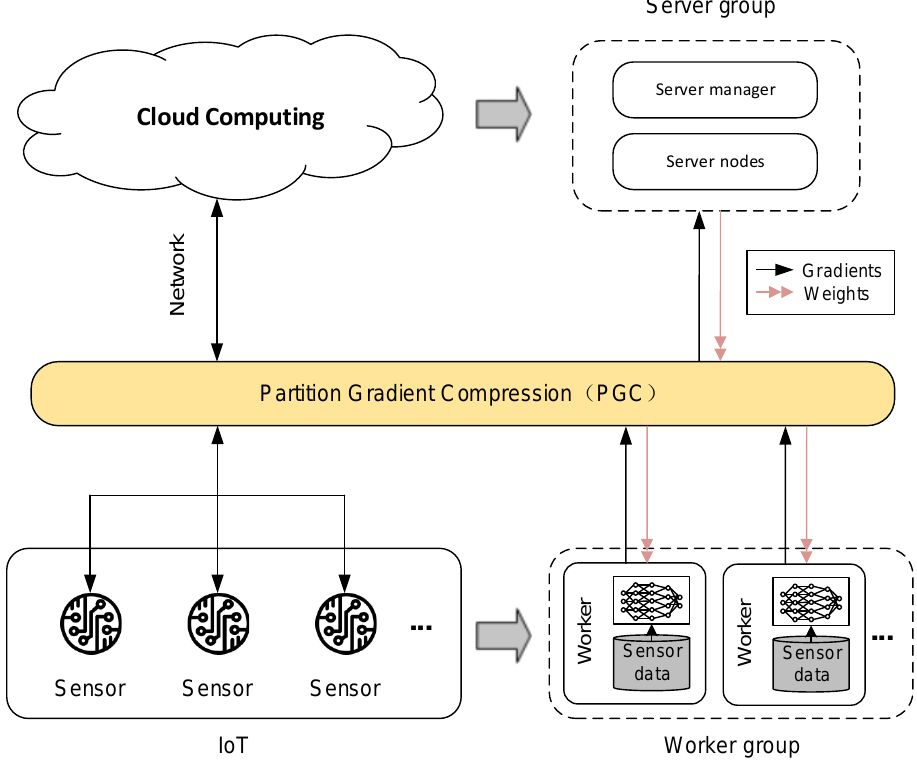
Figure 1. The training scene in IoT is modeled as distributed